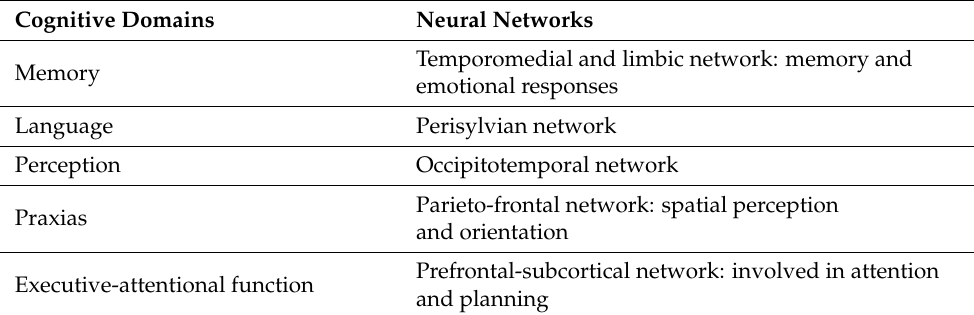
Adapted from [22]. Table 3. Domains to be evaluated and the networks involved. Cognitive